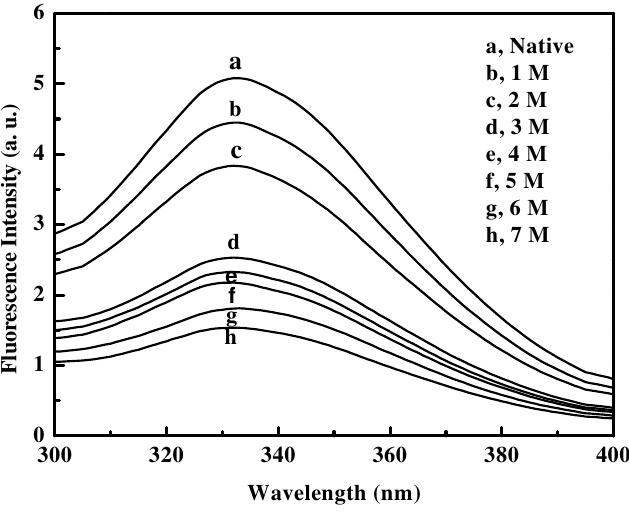
Figure 3 . Quenching of tryptophan fluorescence of sLP at various Acrylamide concentrations (a) Native sLP (b) 0.05M (c) 0.1M (d)0.15M (e)0.18M (f) 0.22M (g) 0.26 M (h)